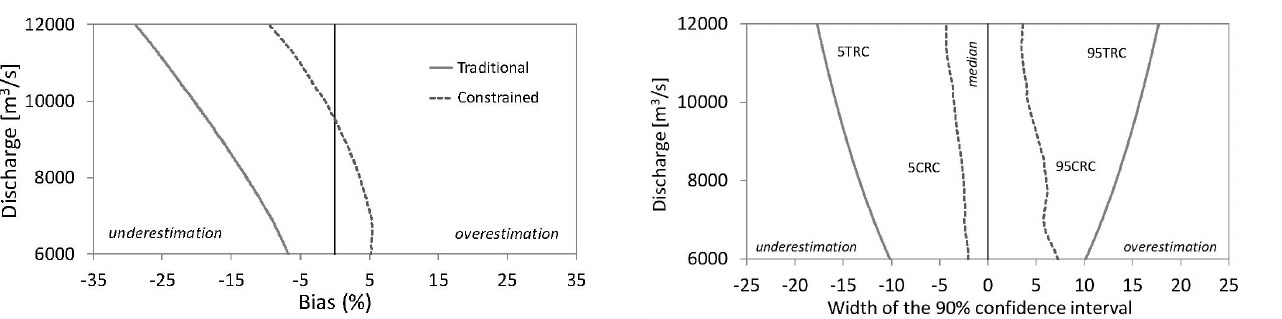
Fig. 8. Width of 90% confidence intervals for Traditional (5TRC and 95TRC, grey lines) and Constrained (5CRC and 95CRC, dashed lines)